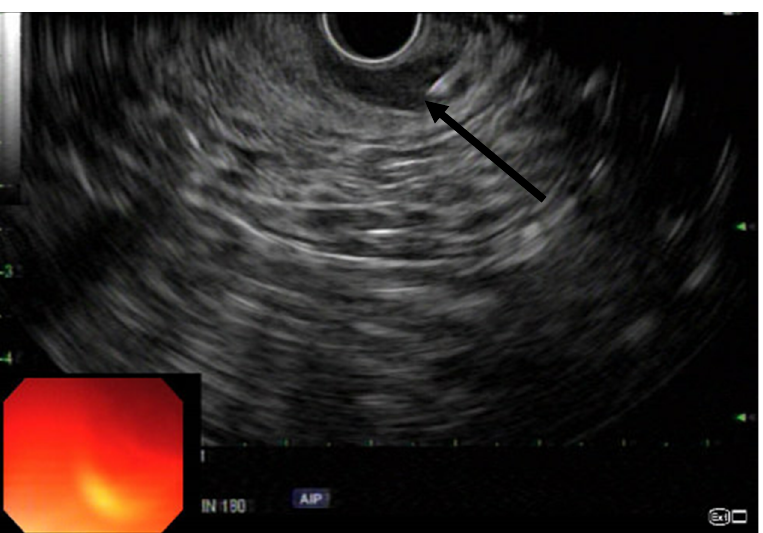
Figure 2. Linear EUS with arrow pointing to IAS.